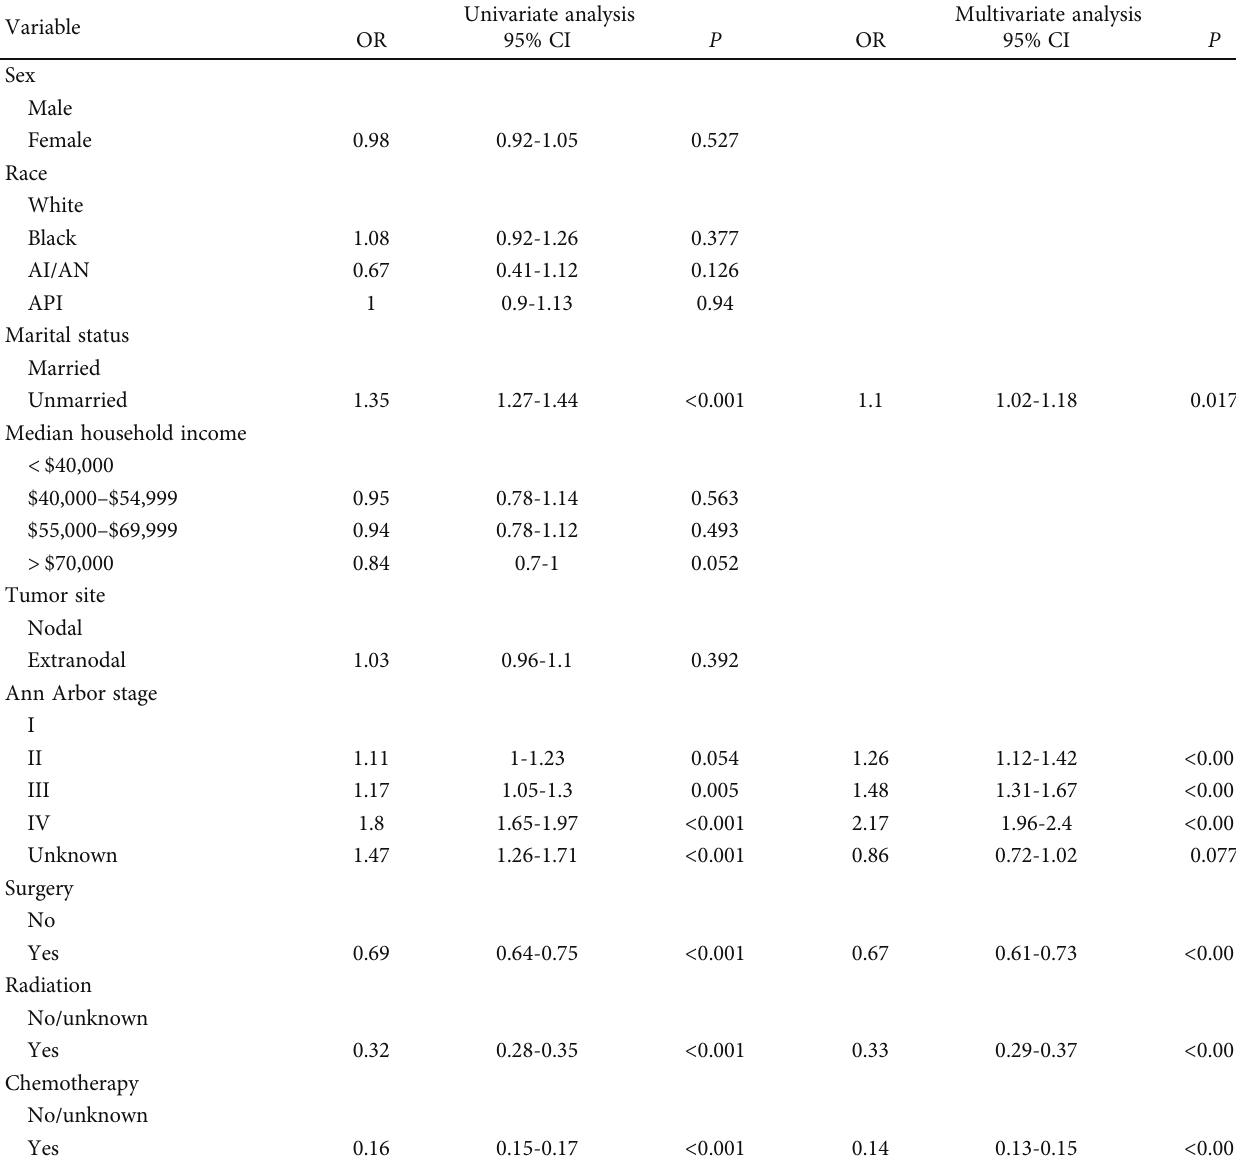
Table 3: Univariate and multivariate logistic analyses of variables associated with risk of OS for older DLBCL